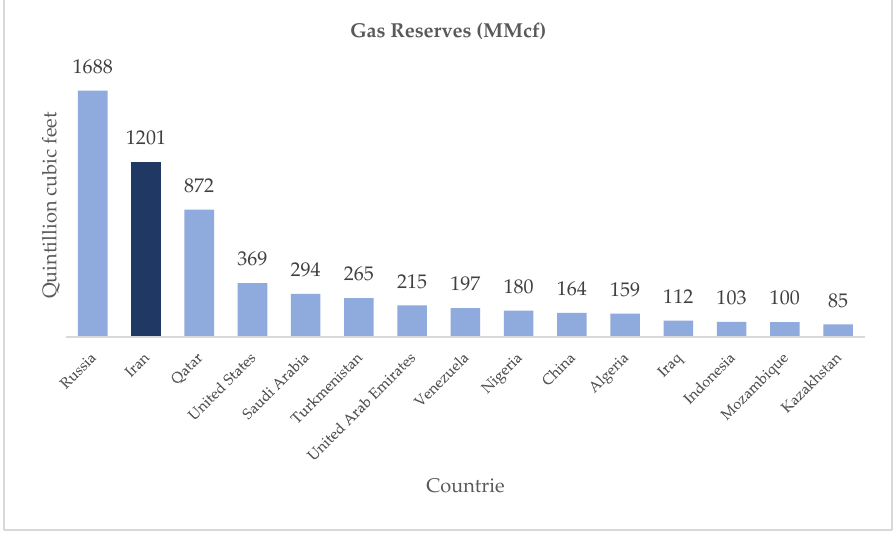
Figure 10. Share of the Iraq’s proven gas reserves of total global reserves of natural gas in 2020, % [36].